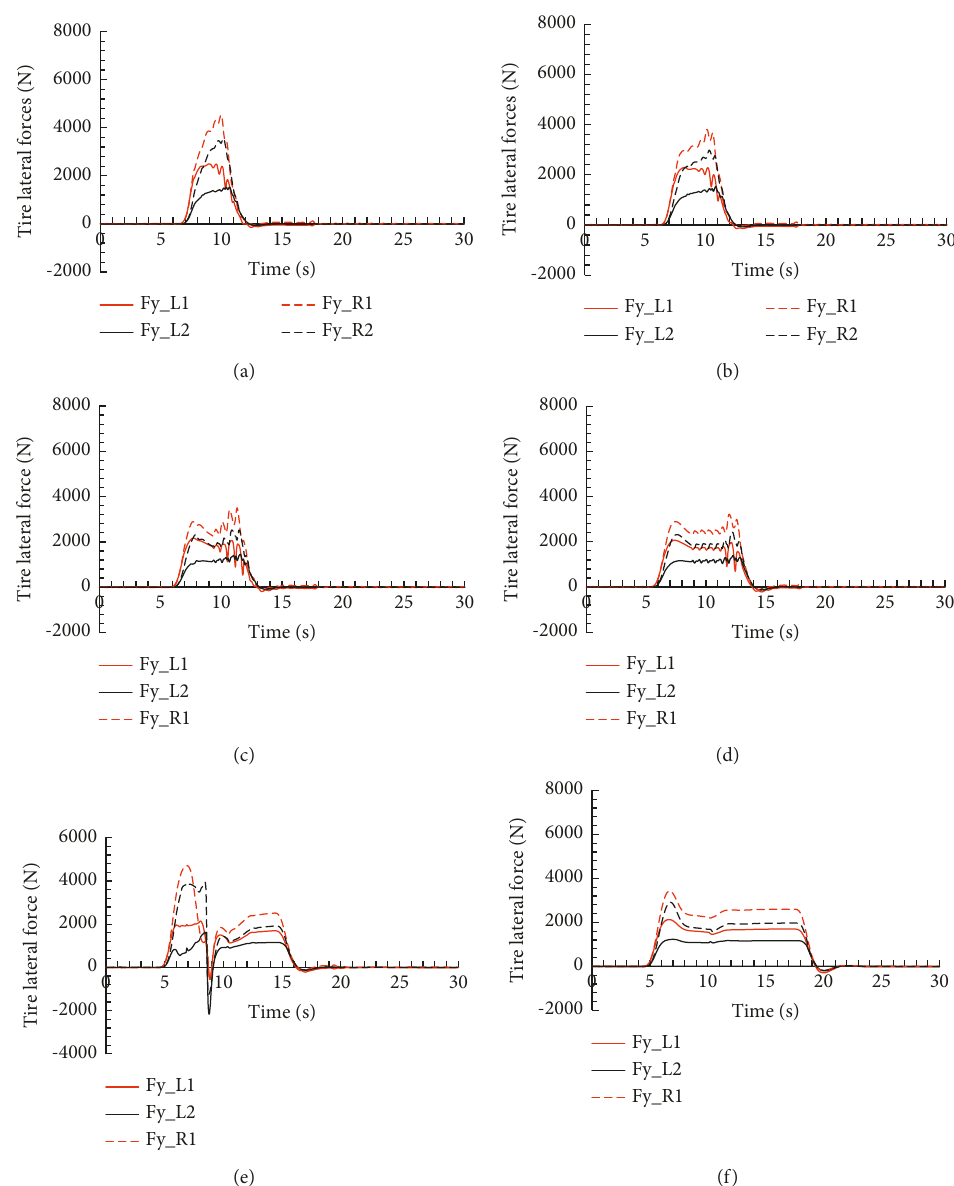
Figure 18: Tire lateral force curves on wet pavement: (a) R